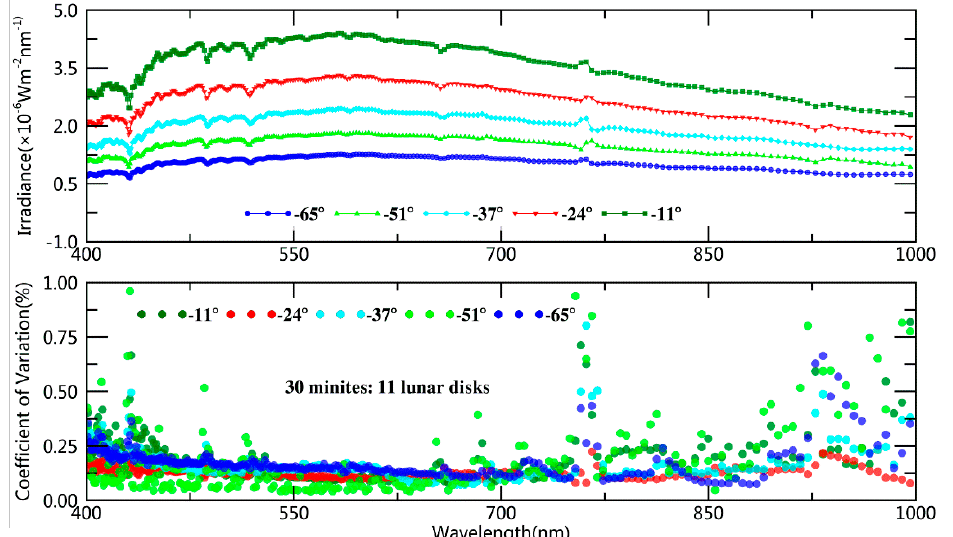
Figure 13. TOA spectral irradiance and stability of the measurement. The upper panel shows the lunar irradiance in different phase angles. The bottom panel shows the stability of the measurement with the wavelength in different phase angles, which is coefficient of variation of 11 measurements (TOA irradiance) within 30 minutes.